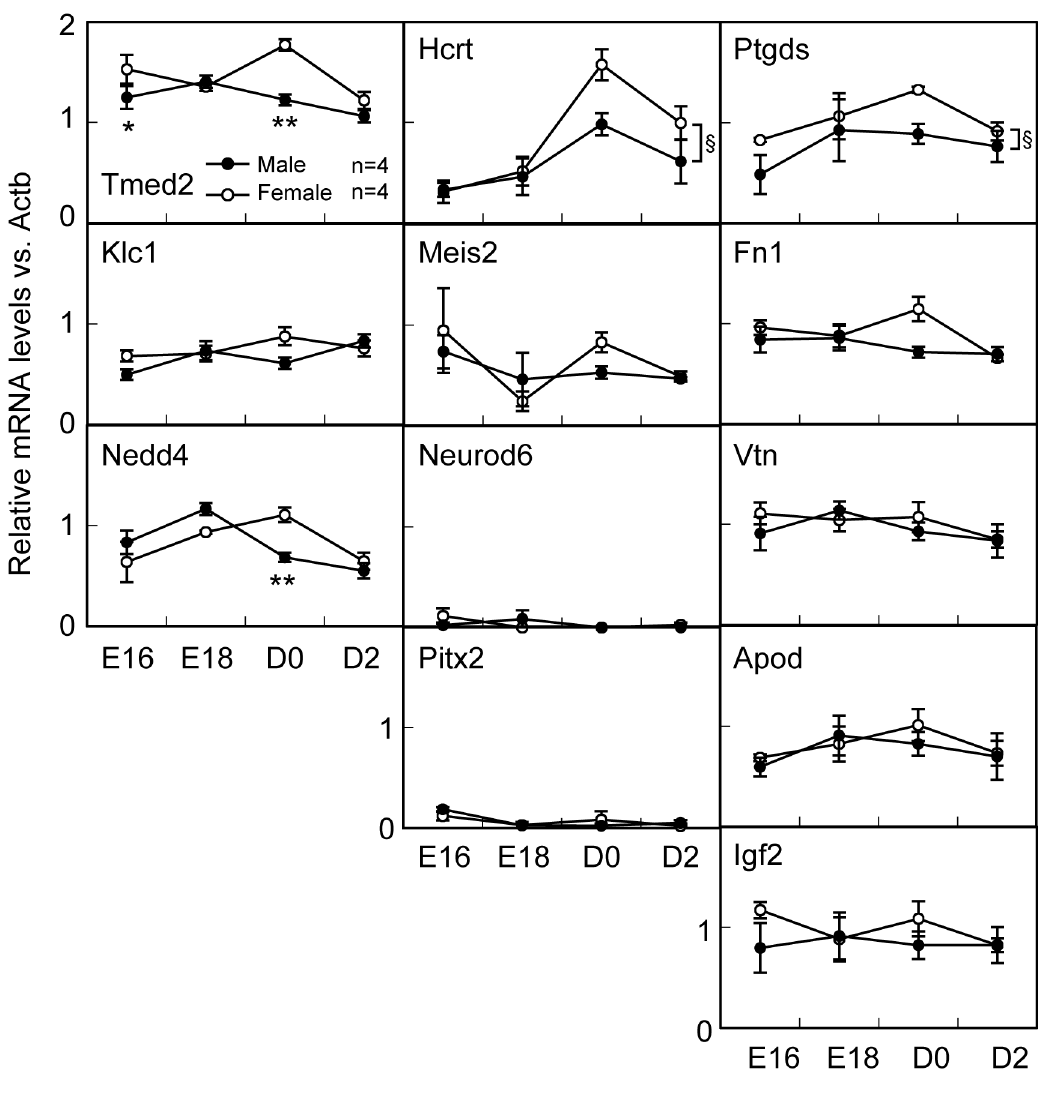
Figure 4. Expressions of Tmed2 , Klc1 , Nedd4, Hcrt , Meis2 , Neurod6 , Pitx2, Ptgds , Vtn , Fn 1 , Apod , and Igf2 genes in the hypothalamus of perinatal intact male and female mouse at embryonic day 16 (E16), E18, the day of birth (D0), and two days after the birth (D2). mRNA levels of these genes were determined semiquantitatively by RT-PCR followed by analysis with Image J from NIH. Gene expression levels in intact male (solid circle) and female hypothalamus (open circle) were indicated in relation to Actb . Values are means±SEM. Values marked with asterisks (* or **) are significantly different from female mice at each time point (P < 0.05 or P < 0.01, two-way ANOVA (sex and age as main factors) followed by the Bonferroni test). Section signs indicate significant effect between sex as a main factor of two-way